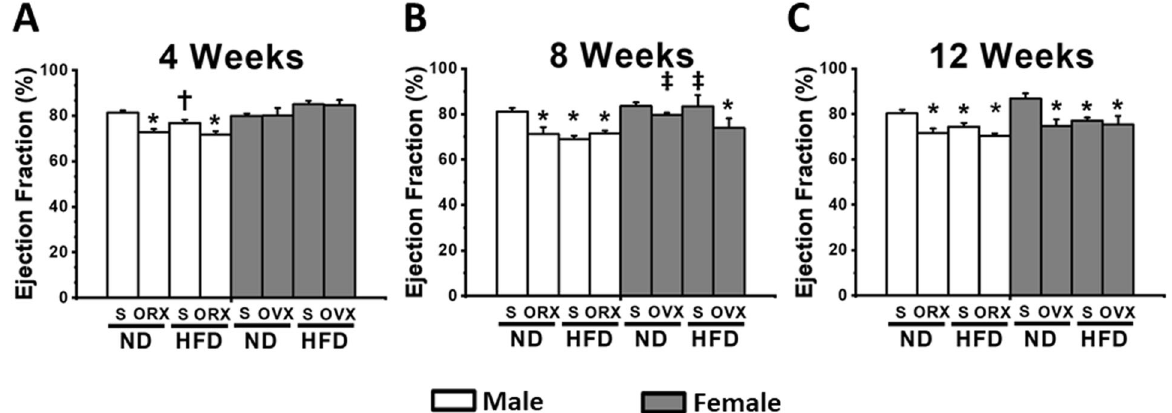
Fig. 1 The effect of sex hormone and dietary consumption on LV function at different time courses (4, 8, and 12 weeks). A The LV function at 4 weeks. B The LV function at 8 weeks. C The LV function at 12 weeks. * P < 0.05 vs sex-matched ND-Sham ( n = 6/group). † P < 0.05 vs male orchiectomized rats ( n = 6/group). ‡ P < 0.05 vs female high-fat diet-fed ovariectomized rats ( n = 6/group). S sham, ND normal diet, HFD high- fat diet, ORX orchiectomized rats, OVX ovariectomized rats.